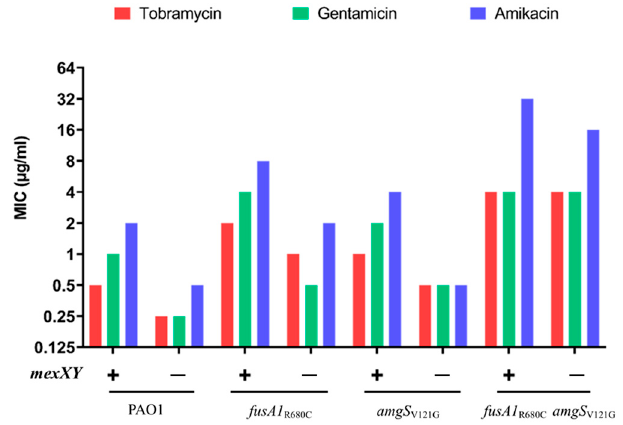
Figure 2. The effects of fusA1 and amgS mutations in the absence of mexXY . The MICs of tobramycin, gentamicin and amikacin were measured for the PAO1 strain with fusA1 or amgS mutations, and their isogenic mexXY mutants. The presence and absence of mexXY are represented as “+” and “ − ”, respectively.